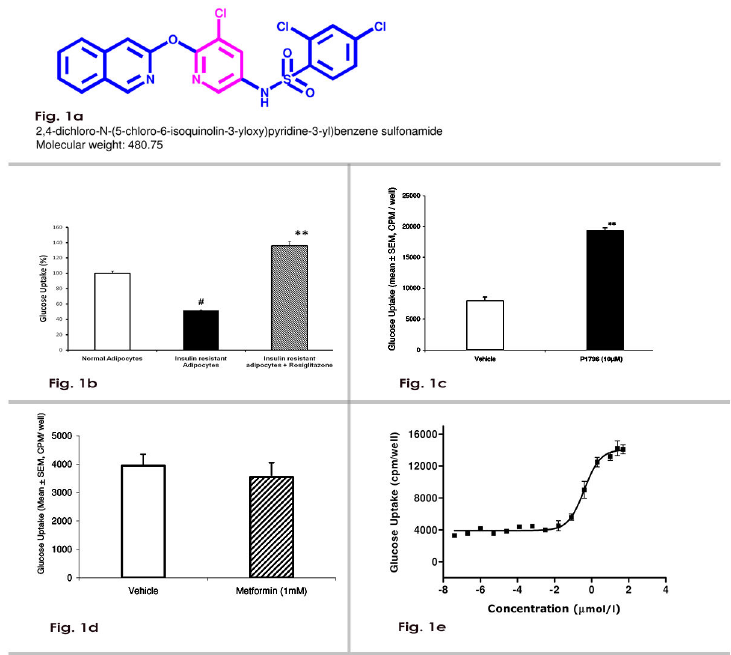
Figure 1. P1736 acts as a potent in vitro insulin sensitizer. a , Chemical structure of P1736. b , Insulin stimulated glucose uptake in normal adipocytes(empty bar), insulin resistant adipocytes(solid bar) and insulin resistant adipocytes treated with rosiglitazone (bar with stripes). c , Glucose uptake in the dexamethasone - induced insulin resistant adipocytes exposed to vehicle(empty bar) or P1736 (10 µM, solid bar). d , Glucose uptake in the dexamethasone-induced insulin resistant adipocytes exposed to vehicle (empty bar) or metformin (1.0mM, bar with stripes). e , Dose response of P1736 on glucose uptake in dexamethasone - induced insulin resistant adipocytes. Data are expressed as Mean ± SEM. Difference between vehicle and treatment groups were statistically evaluated by t-test., # p<0.01 compared to normal adipocytes, **p<0.01 compared to insulin resistant adipocytes